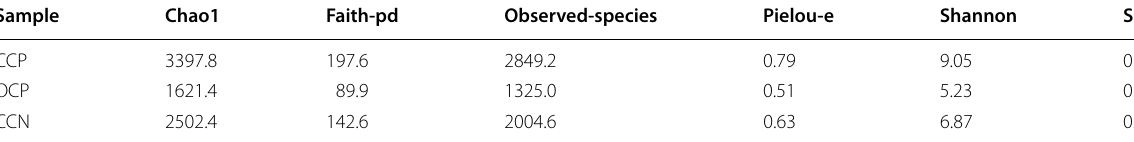
Sample Chao1 Faith-pd